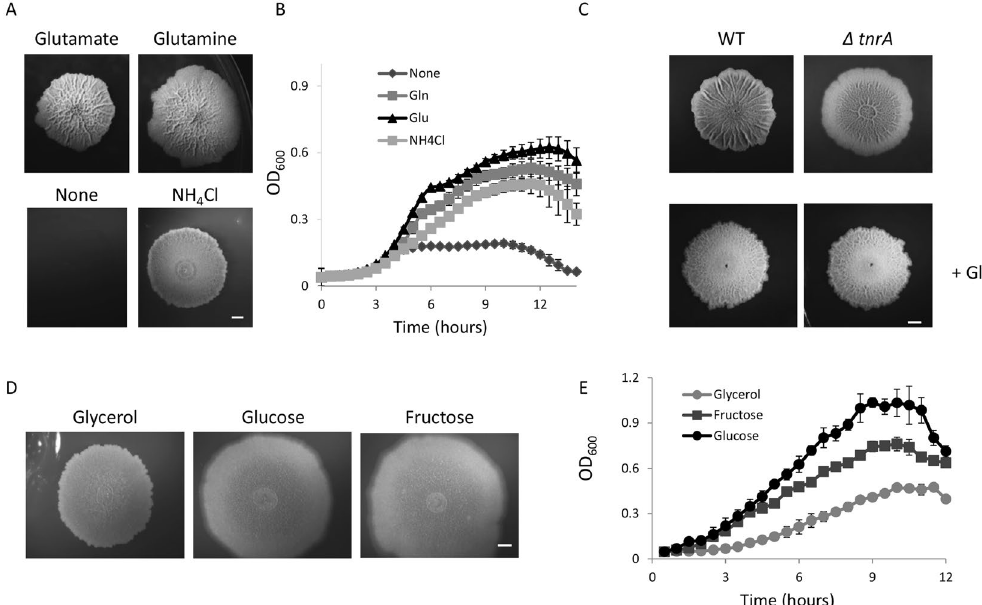
Figure 1. Glutamate and glutamine is an essential nitrogen source for biofilm development. ( A ) Biofilms were grown on solid medium containing MS salts and glycerol as a carbon source as described in the materials and methods, to which different nitrogen sources were added; glutamate, glutamine (upper panel), ammonium chloride or no nitrogen source (bottom panel). The nitrogen sources were applied in an equimolar ratio to the original glutamate concentration in MSgg medium. Biofilms were grown for three days at 30 °C. Images of colonies and pellicles were acquired with a stereomicroscope (Zeiss) and were optimized for contrast and brightness, with adjustments kept consistent between control and treatments. Scale bar corresponds to 2 mm. ( B ) Planktonic growth of wild type cells grown at 30 °C with shaking in liquid biofilm medium. Planktonic growth in medium supplemented with different nitrogen sources was monitored by measuring OD 600 in a microplate reader. Results reflect averages of seven wells within one experiment. Errors bars represent the corresponding standard deviations. A representative of six independent experiments is shown. ( C ) TnrA, a transcription factor that coordinates glutamine and glutamate synthesis has a role in biofilm development. Parental wild-type strain and its tnrA mutant derivative were grown on either MSgg (top), or MSgg supplemented with 1% glutamine (bottom) for three days. Scale bar corresponds to 2 mm. ( D ) The effect of altering carbon sources on biofilm formation Biofilms were grown on solid medium containing MS salts, ammonium chloride and the indicated carbon sources (0.5%) as described in the materials and methods. Biofilms were grown for three days at 30 °C. Images of colonies were acquired with a stereomicroscope (Zeiss) and were optimized for contrast and brightness, with adjustments kept consistent between control and treatments. Scale bar corresponds to 2 mm. ( E ) Planktonic growth of wild type cells grown at 30 °C with shaking in liquid. Planktonic growth in the biofilm media supplemented with different nitrogen sources was monitored by measuring OD 600 in a microplate reader. Results reflect averages of five wells within one experiment together. Errors bars represent the corresponding standard deviations. A representative of three independent experiments is shown. All curves differed from each other with a p-value <